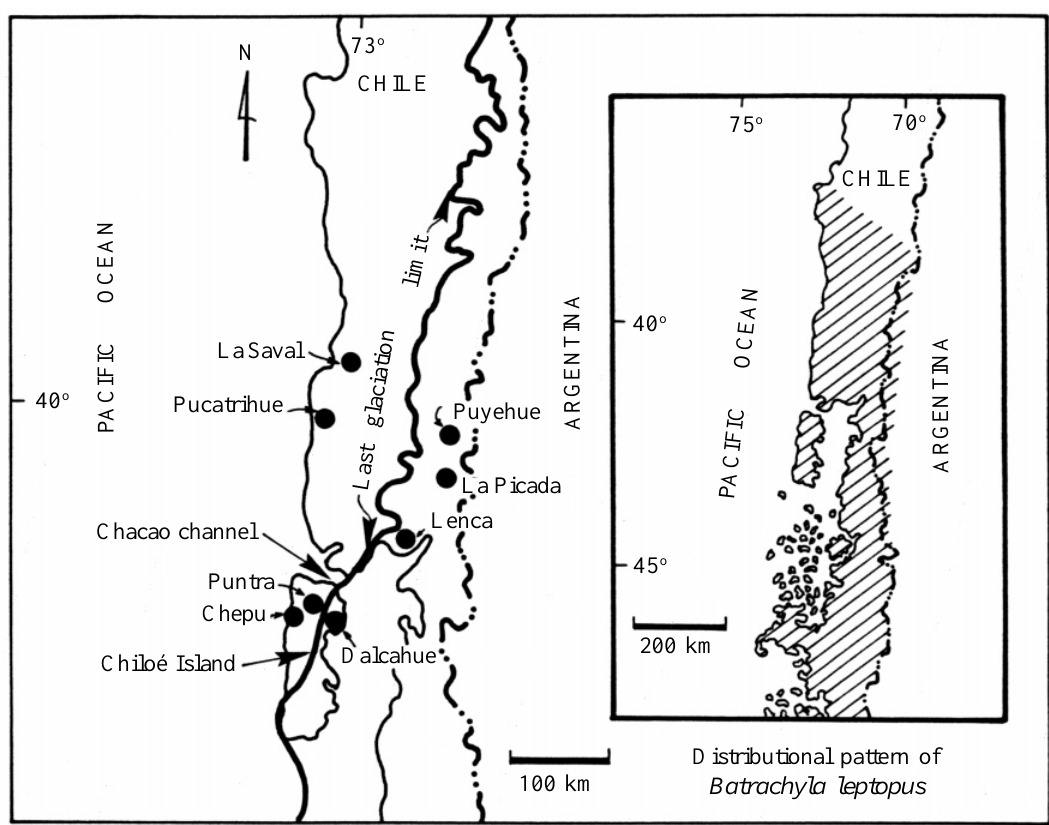
Figure 1 - Map of the locations where populations of Batrachyla leptopus were collected in southern Chile. Inset: Distribution of B. leptopus in southern Chile and